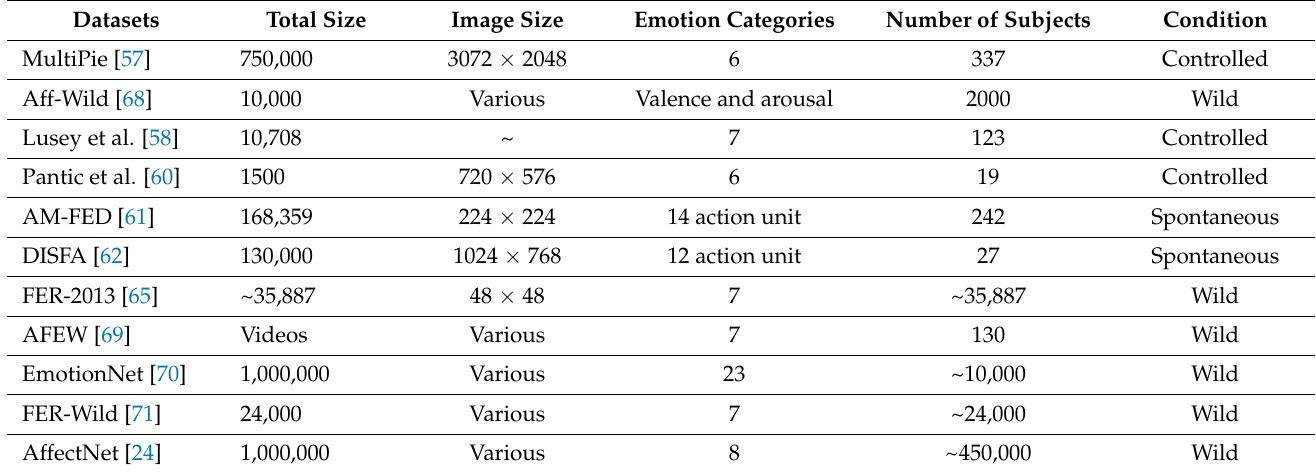
Table 2. A comparison of existing facial emotion recognition datasets.